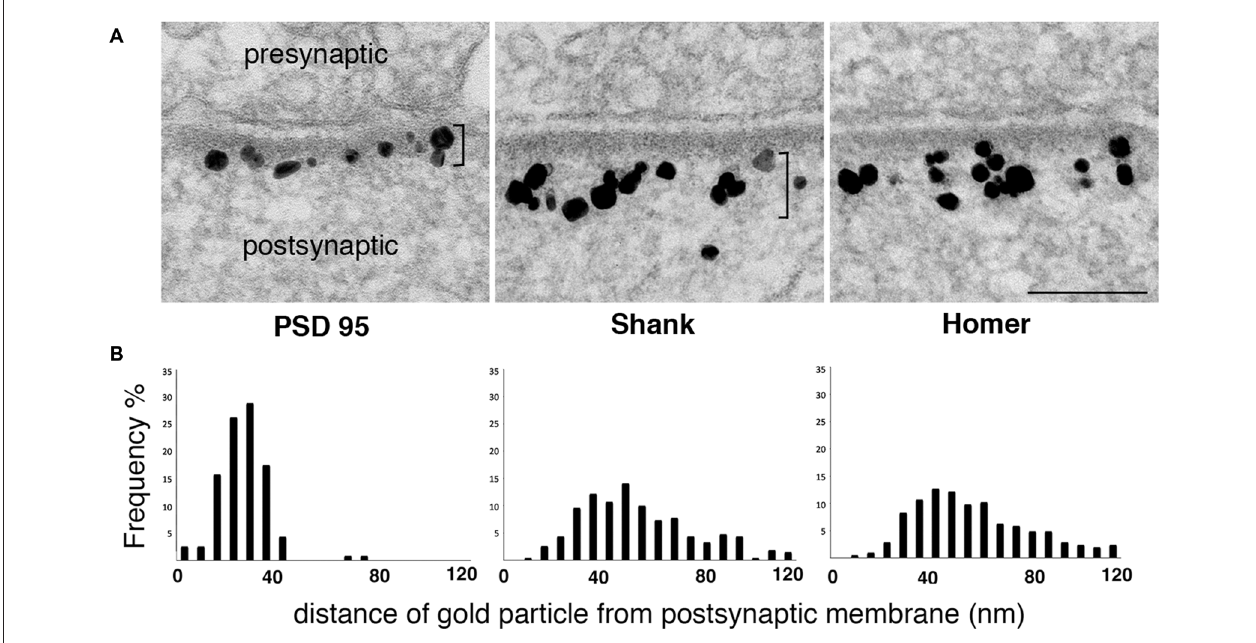
FIGURE 2 | Label for two PSD scaffold proteins, Shank and Homer, lies mostly outside the PSD core. (A) Electron micrographs of asymmetric synapses in cultured hippocampal neurons immunogold labeled with antibodies for three major PSD scaffold proteins. Silver-enhanced gold label appears as black particles of heterogeneous size (EM in middle panel from Tao-Cheng et al., 2015). The PSD core with PSD-95 label and the PSD pallium with Shank and Homer labels are marked by brackets on the left and middle panels respectively. Scale bar: 0.1 µ m. (B) Frequency histograms depicting the distribution of label at the postsynaptic compartment in a typical experiment. While label for PSD-95 is within the electron-dense material, label for Shank and Homer is concentrated in a deeper region we designate as the pallium of the